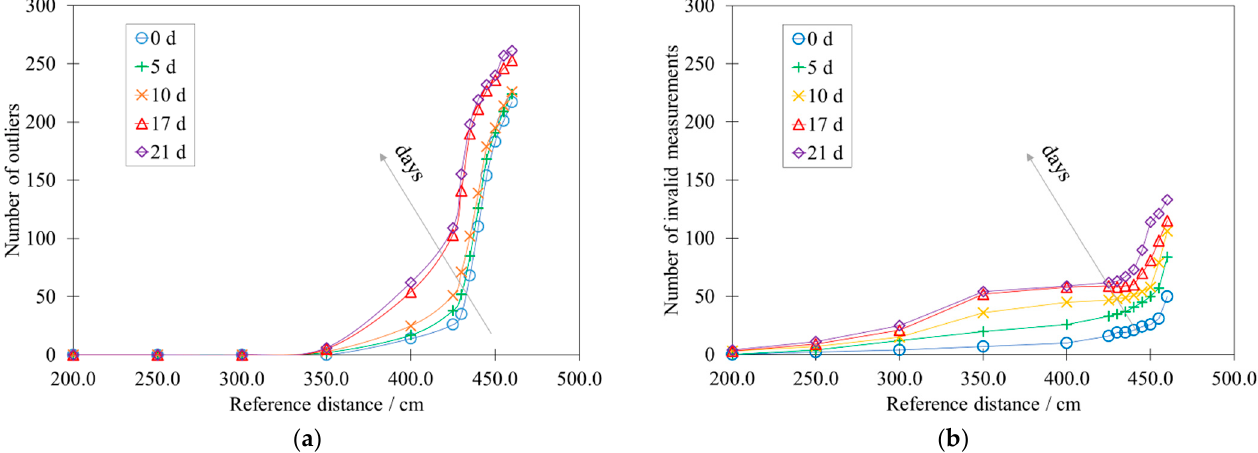
Figure 9. Influence of the accelerated aging on ( a ) the number of outliers and on ( b ) the number of invalid measurements.